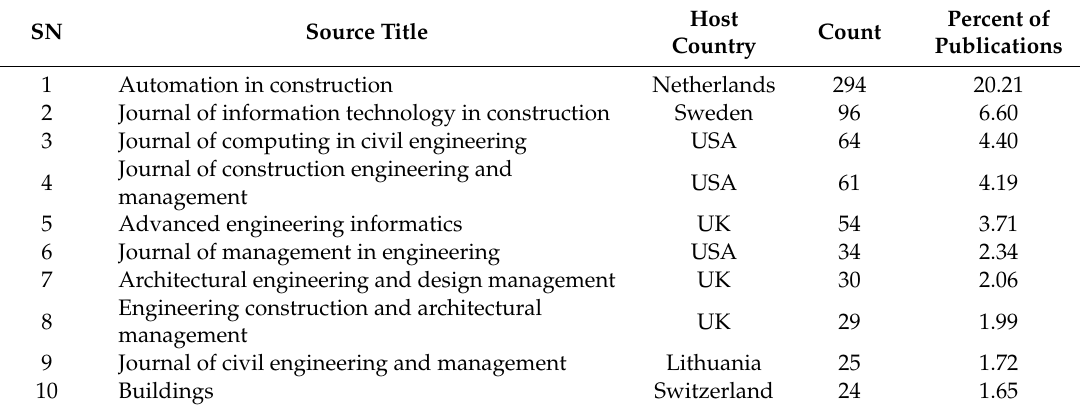
Table 6. Top 10 Journals for BIM research in